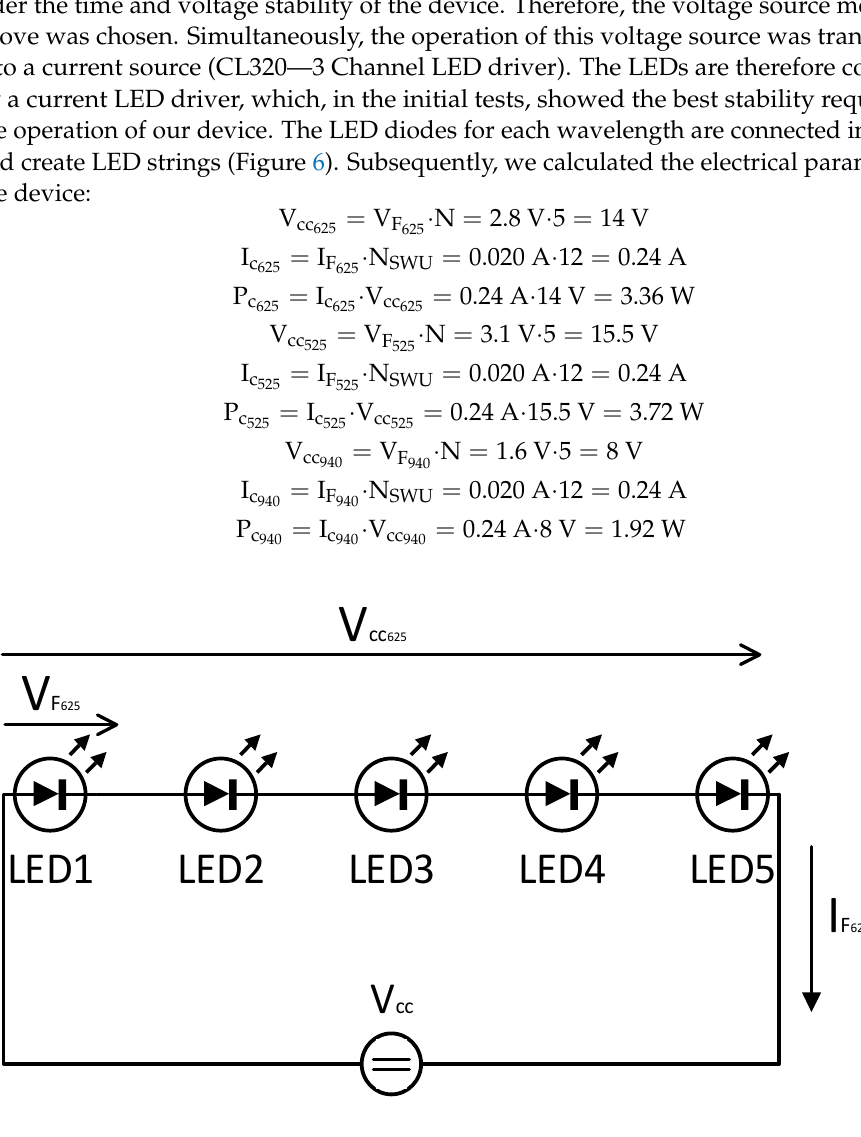
5 4 Figure 7. Wiring diagram of LED driver, CL320, adapted from [30].